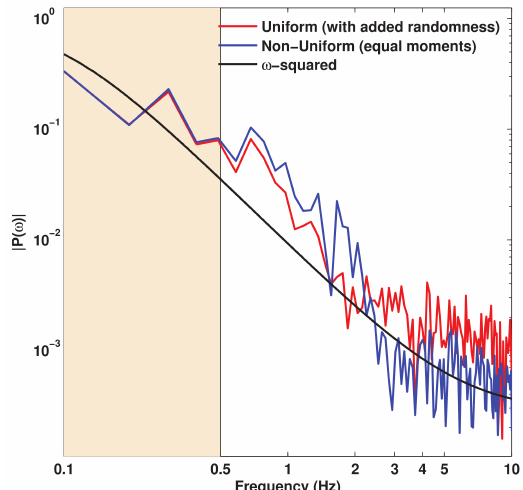
Figure 20. Comparison of the amplitude spectra of the transfer functions [p(t)] for the 2004 Parkfield earthquake. EGF magnitude: 2.5. Black line: Theoretical value. Red line: Uniform distribution. Blue line: Non-uniform distribution used in this